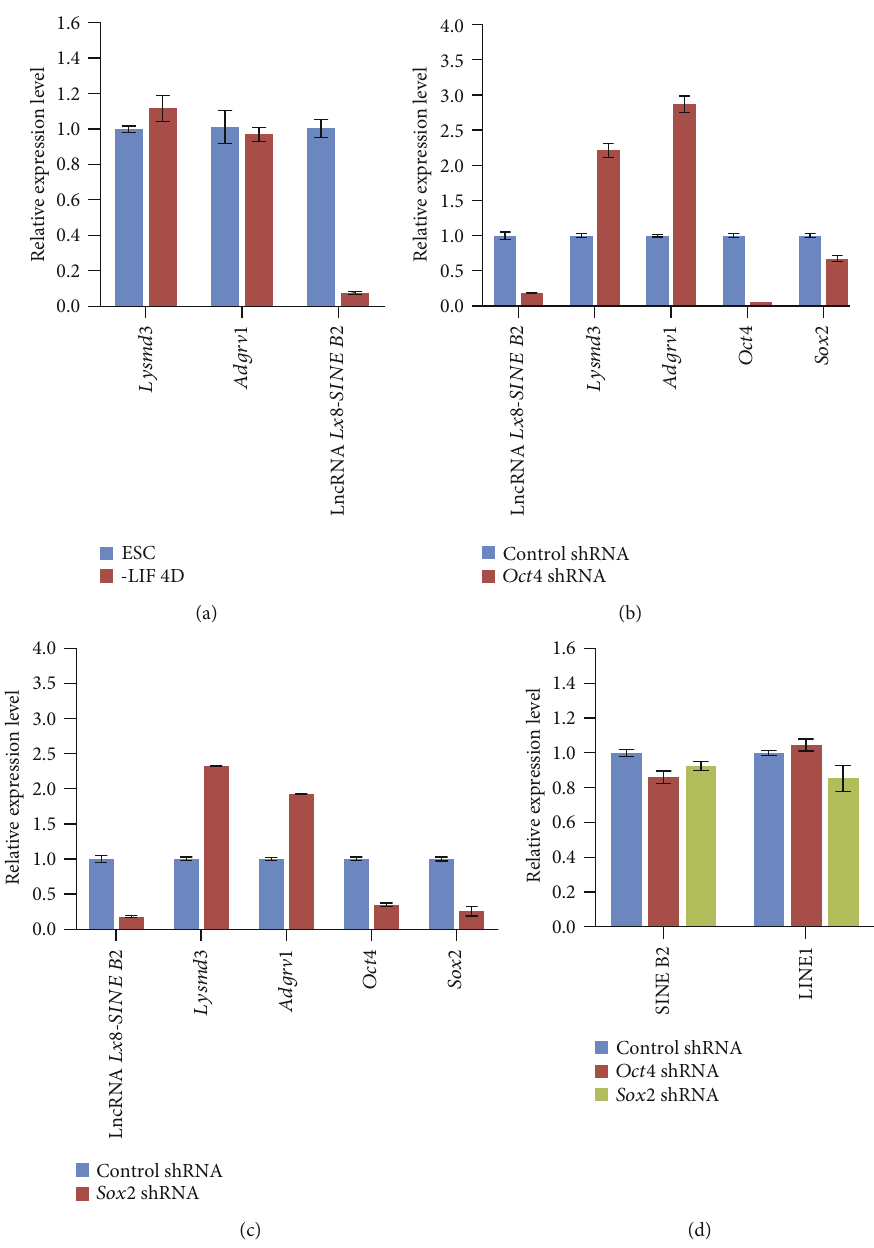
Figure 5: Expression of neighboring genes of Lx8-SINE B2 . (a) qPCR analysis of neighboring genes ( Adgrv1 and Lysmd3 ) of lncRNA Lx8- SINE B2 in ESCs cultured with or without LIF; (b, c) RT-qPCR analysis of lncRNA Lx8-SINE B2 , Adgrv1 , Lysmd3 and pluripotent genes ( Oct4 and Sox2 ) expression after depletion of Oct4 (b) or Sox2 (c) in E14 ESCs. The data are represented as mean ± s : e : m : from three biological replicates. (d) Expression of LINE1 and SINE B2 after depletion of Oct4 or Sox2